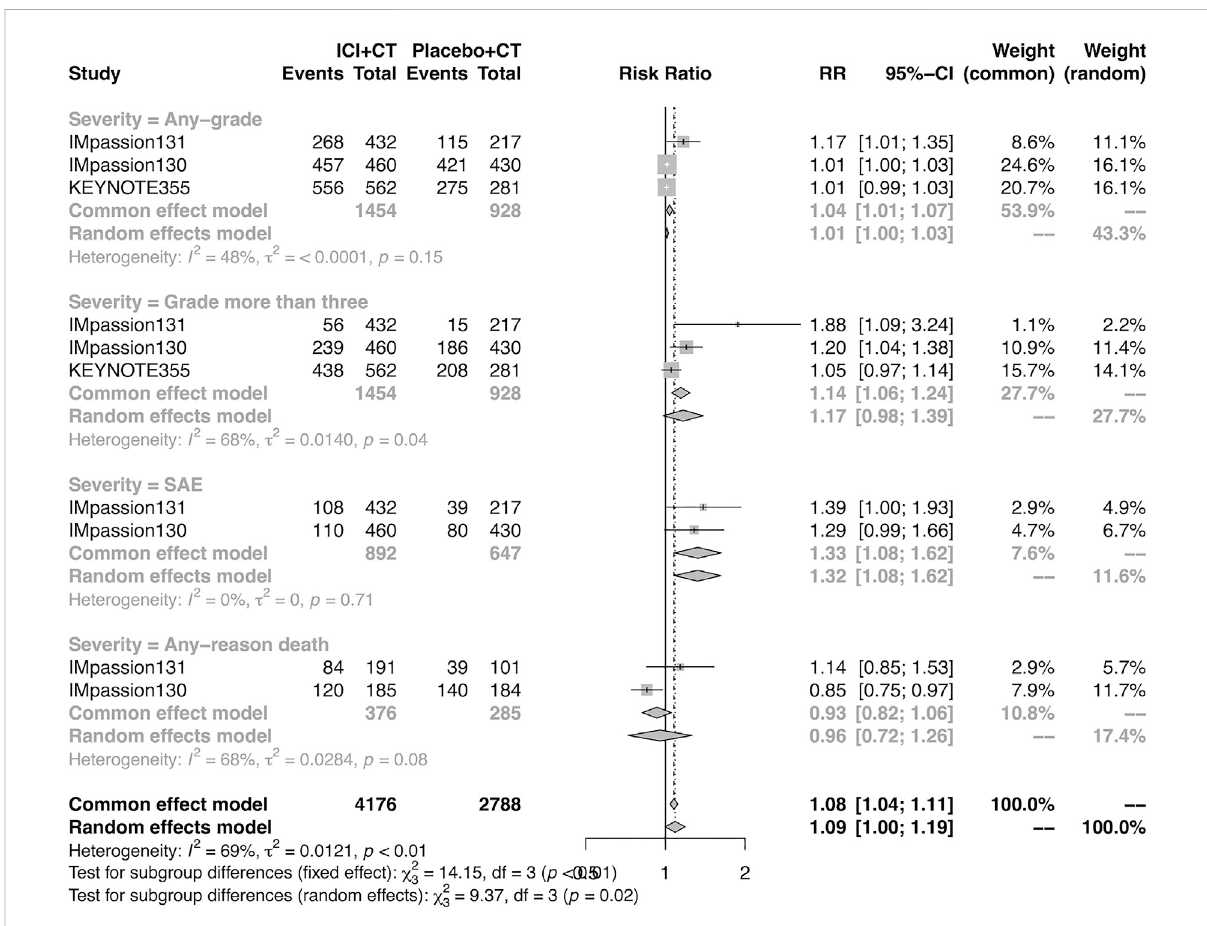
FIGURE 6 Pooled AEs in adjuvant therapy clinical trials. SAEs, severe adverse events; RR, relative risk; 95% CI, 95% con fi dence interval; ICIs, immune checkpoint inhibitors; CT,